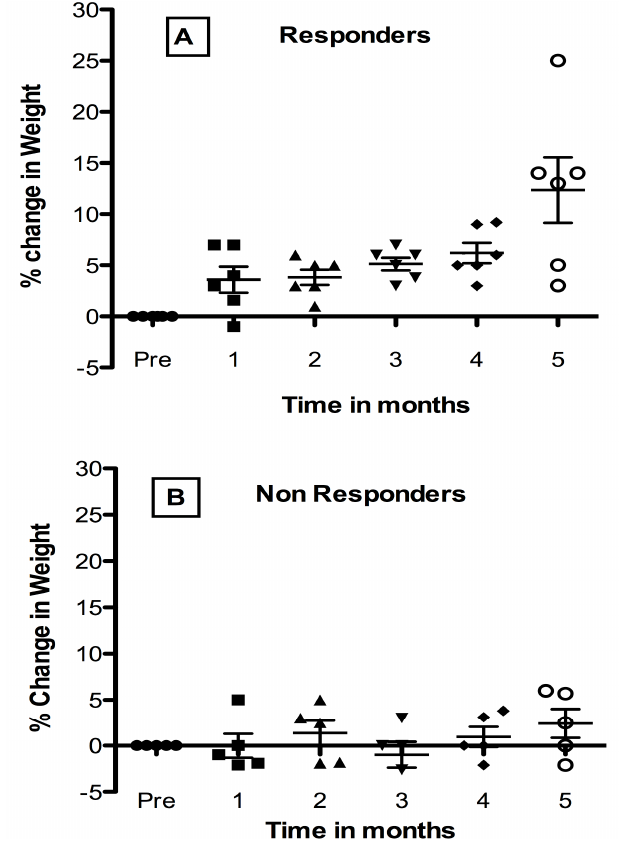
Figure 2. Effect of Oral Probiotic Lp299v on Weight in Congenital HIV-1 Infection. Data show mean percent change ± SD from the 4-month pretreatment period compared to post-treatment months. Variance was significant for responders (panel A). Responder pair-wise differences at post-month 5 compared to pretreatment ( p < 0.0001) months were found. See